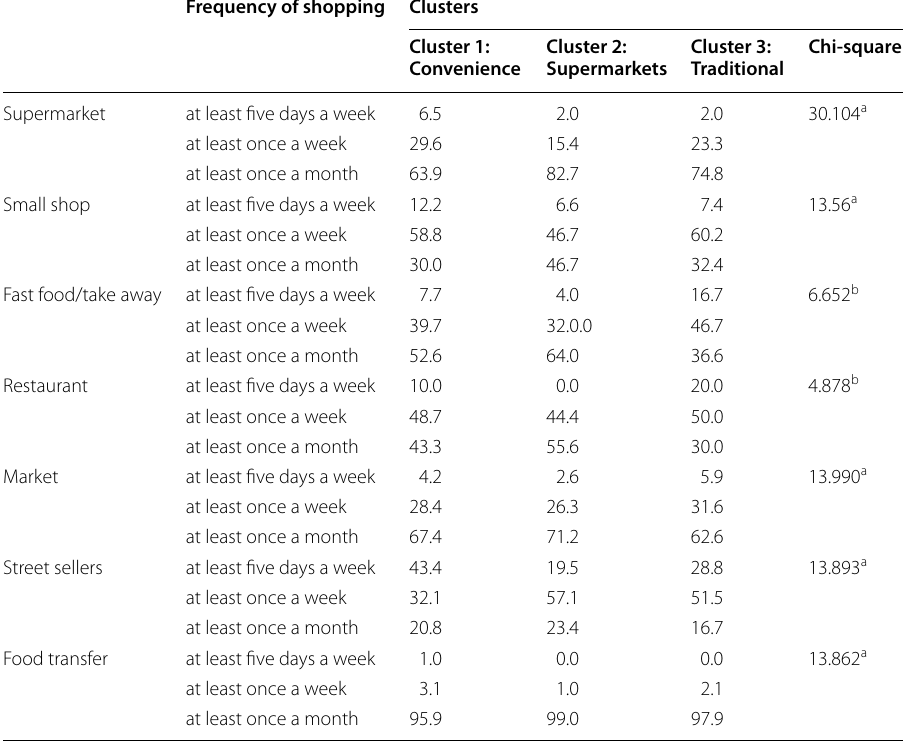
Table 5 Food sourcing frequency by food